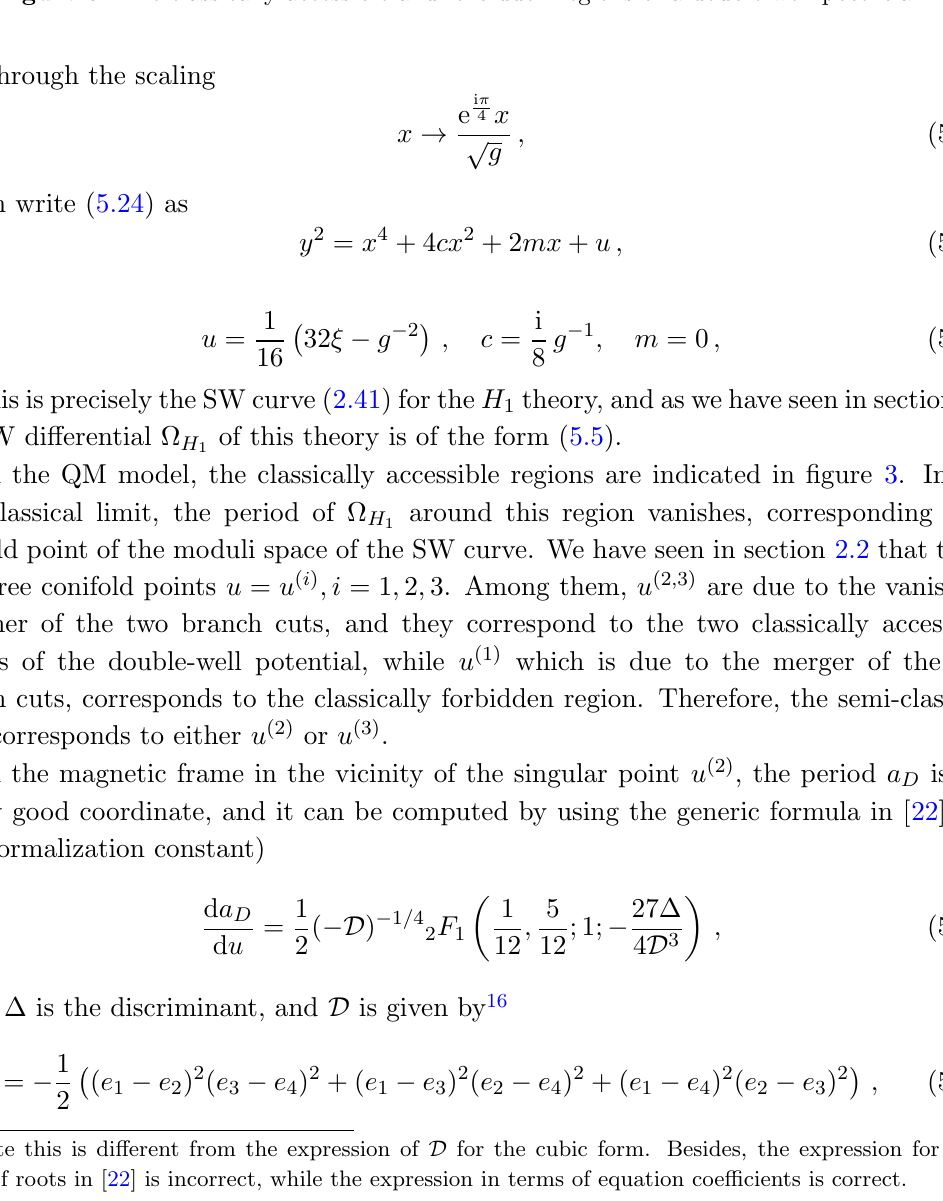
Figure 3 . The classically accessible and forbidden regions of a double-well